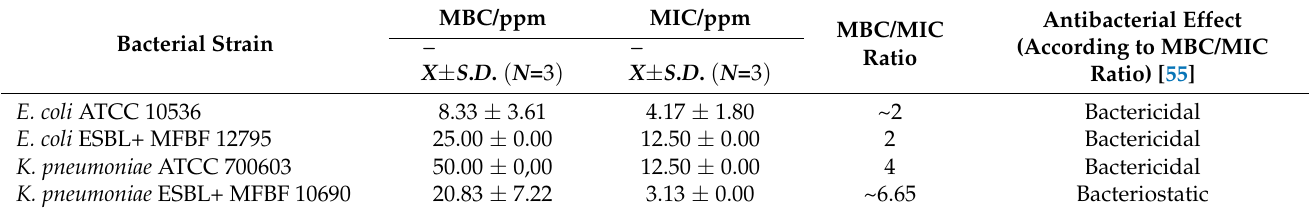
Table 2, nPt has an antibacterial effect against all the tested bacterial strains in vitro. Table 2. MBC and MIC values for colloidal solutions of platinum nanoparticles for the tested bacterial strains of E. coli and K. pneumoniae in a saline medium. Concentrations are expressed as ppm (i.e., parts per million ), equal to µ g mL − 1 .